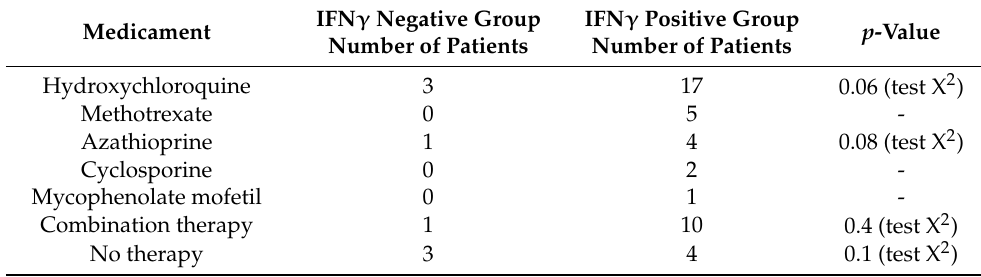
Table 4. The treatment used in pSS patients depending on the concentration of IFN γ